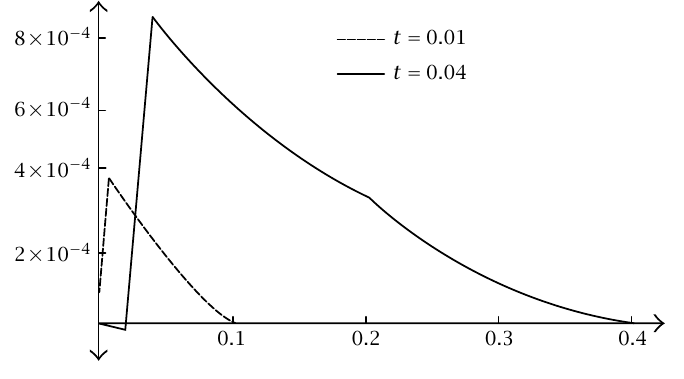
Figure 5.3 . Temperature θ/σ 0 versus x in the ramp-type stress problem.